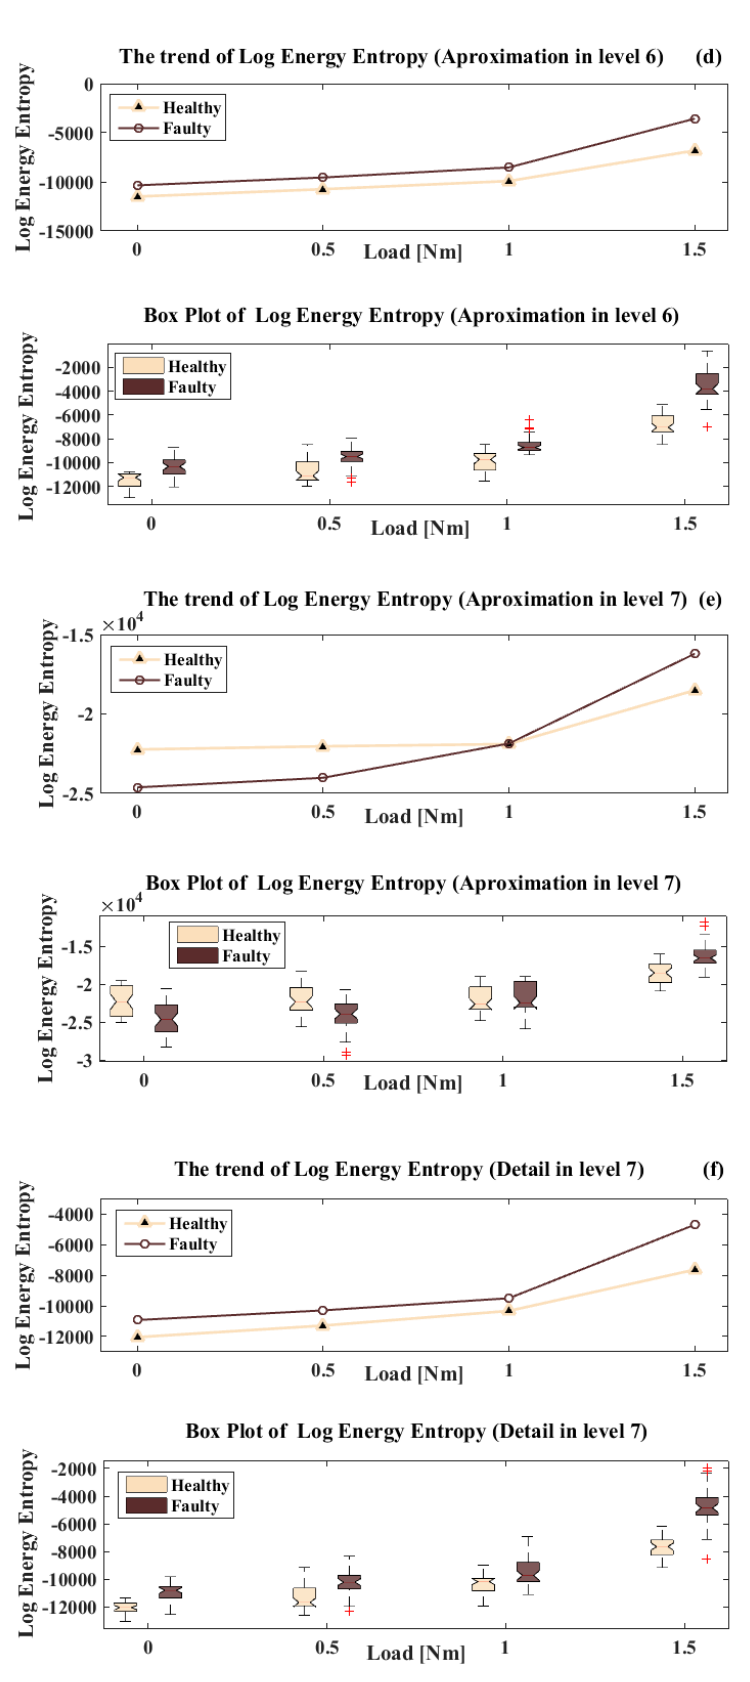
Figure 17. Trend and boxplot for entropy features under different levels of starting load. ( a ) Shannon entropy (A6); ( b ) Shannon entropy (A7); ( c ) Shannon entropy (D7); ( d ) log-energy entropy (A6); ( e ) log-energy entropy (A7); ( f ) log-energy entropy (D7).